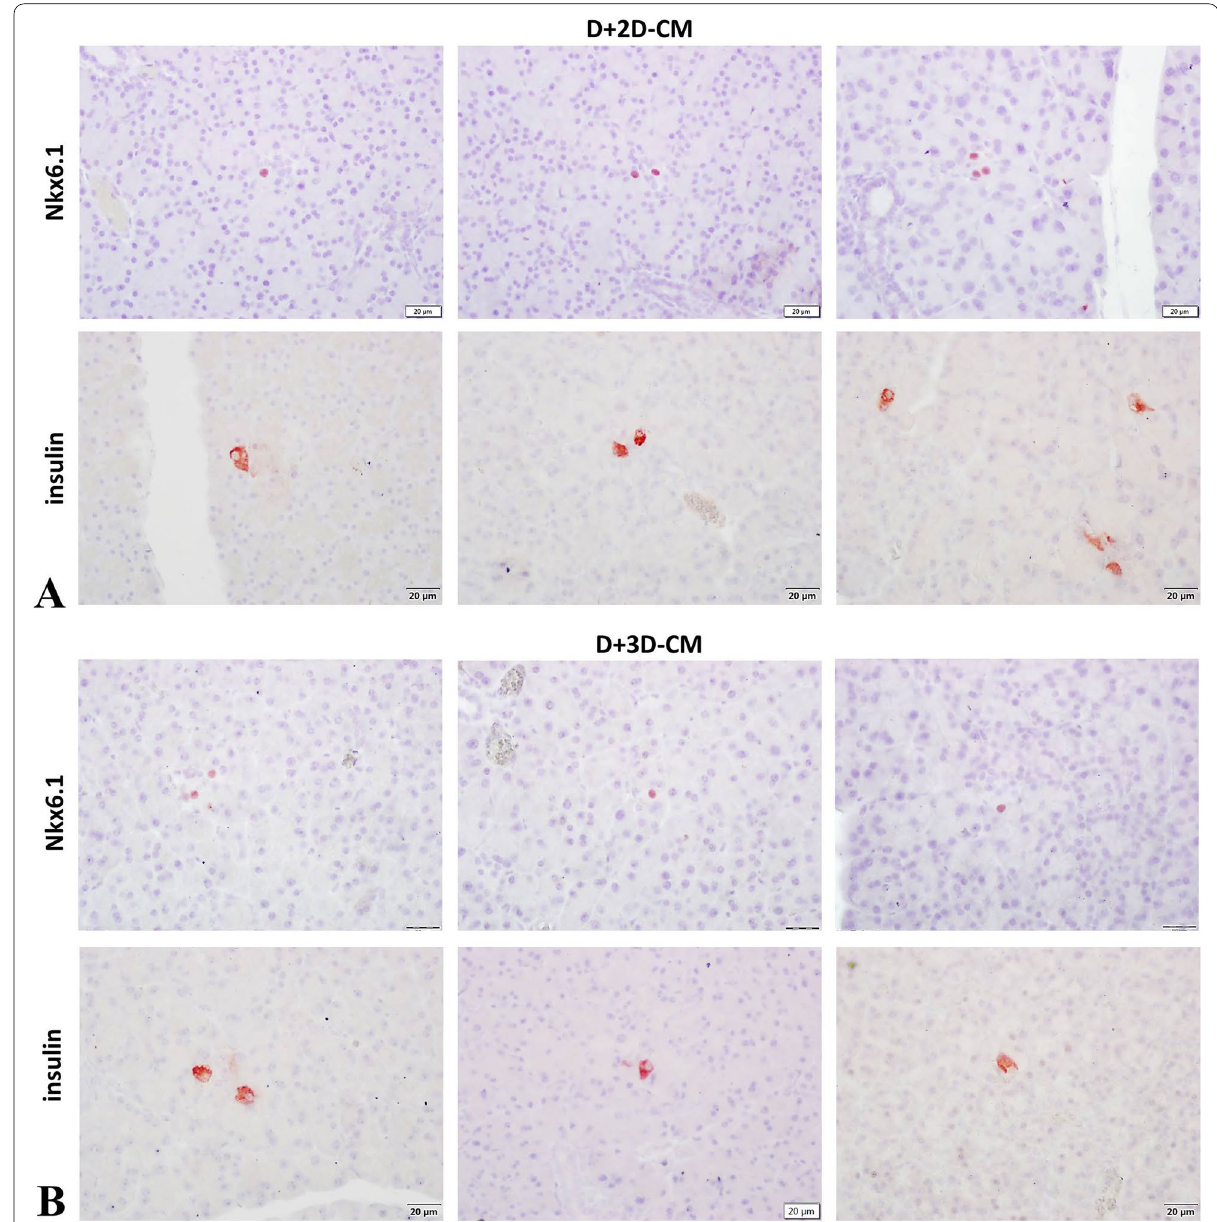
Fig. 7 Nkx6.1 and insulin‑positive cells in the exocrine pancreas. A Micrographs showing Nkx6.1 and insulin‑positive cells in the exocrine pancreas in the D 2D‑CM group. B Micrographs showing Nkx6.1 and insulin‑positive cells in the exocrine pancreas in the D +